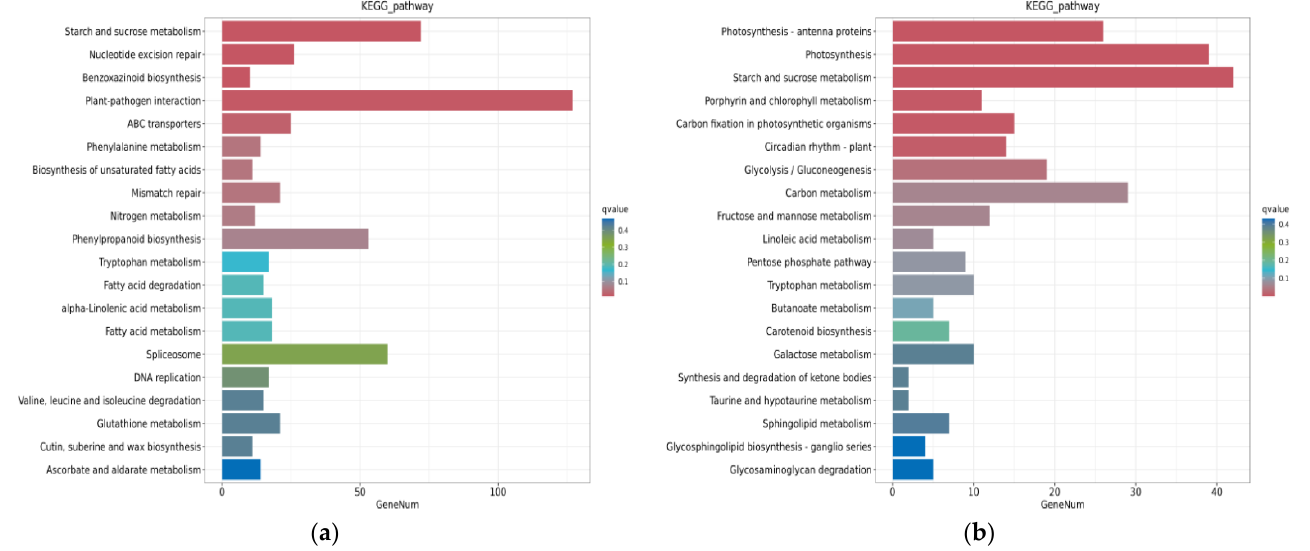
Figure 5. Enrichment analysis of KEGG. ( a ) BS vs. MS KEGG enrichment histogram. ( b ) BR vs. MR KEGG enrichment histogram. The ordinate is for each pathway entry, and the abscissa is the number of genes, i.e., the number of differential genes annotated in this entry. The colors in the columns represent the hypergeometric test q -values.